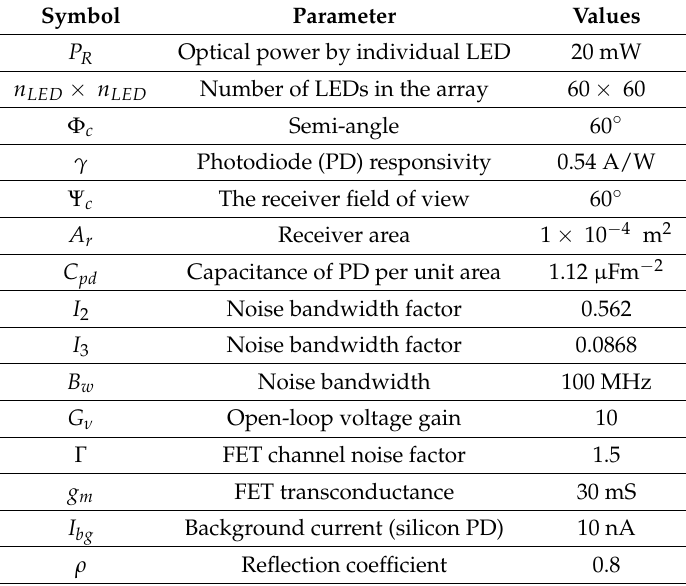
Table 1. Simulation parameters.